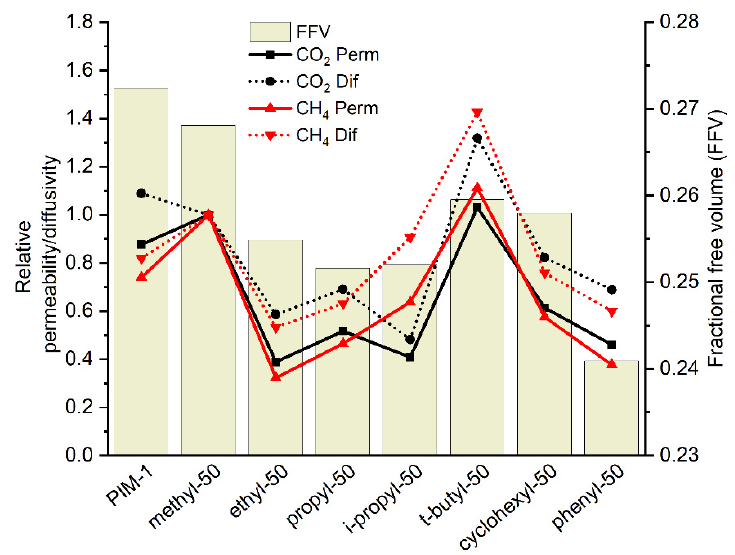
Figure 10. CO 2 and CH 4 relative permeability relative diffusivity and FFV of copolymers. (Relative permeability or diffusivity: copolymer gas permeability or diffusivity are normalized to methyl-50 gas permeability or diffusivity.)